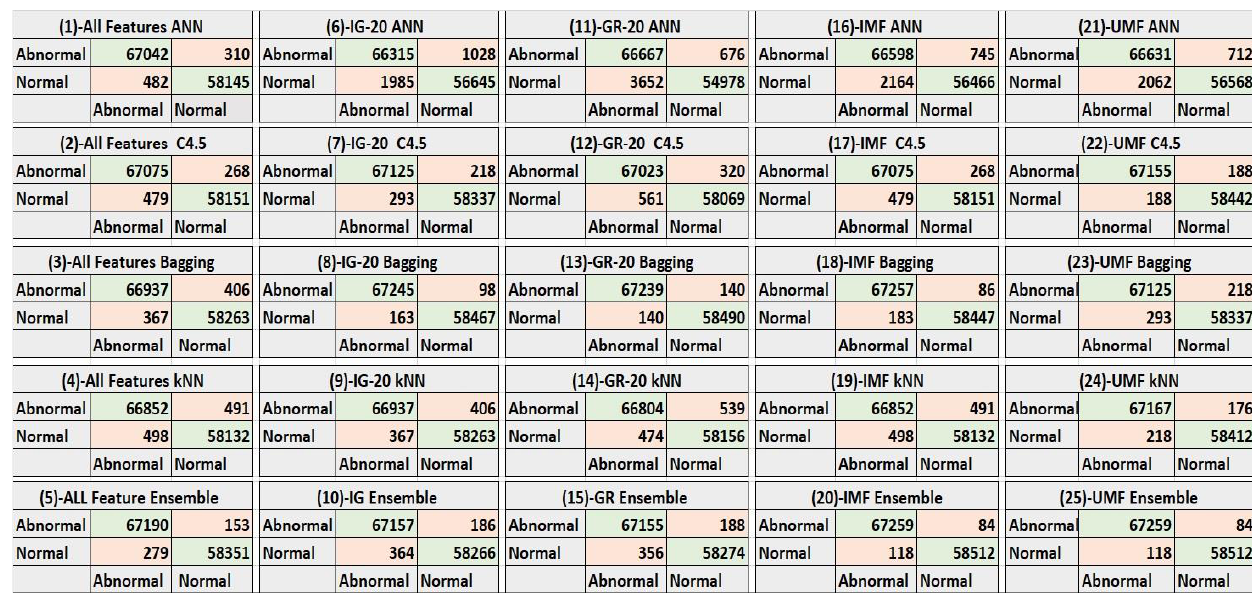
Figure 8. Confusion matrix yielded by the five various models (2-classes) of NSL-KDD